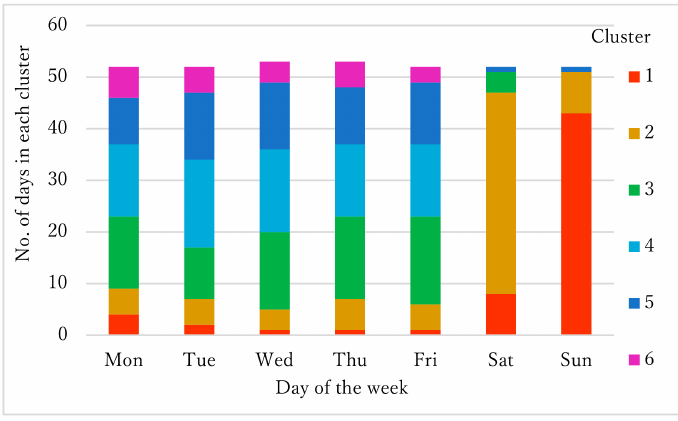
Figure 12. The number of days per cluster by day of the